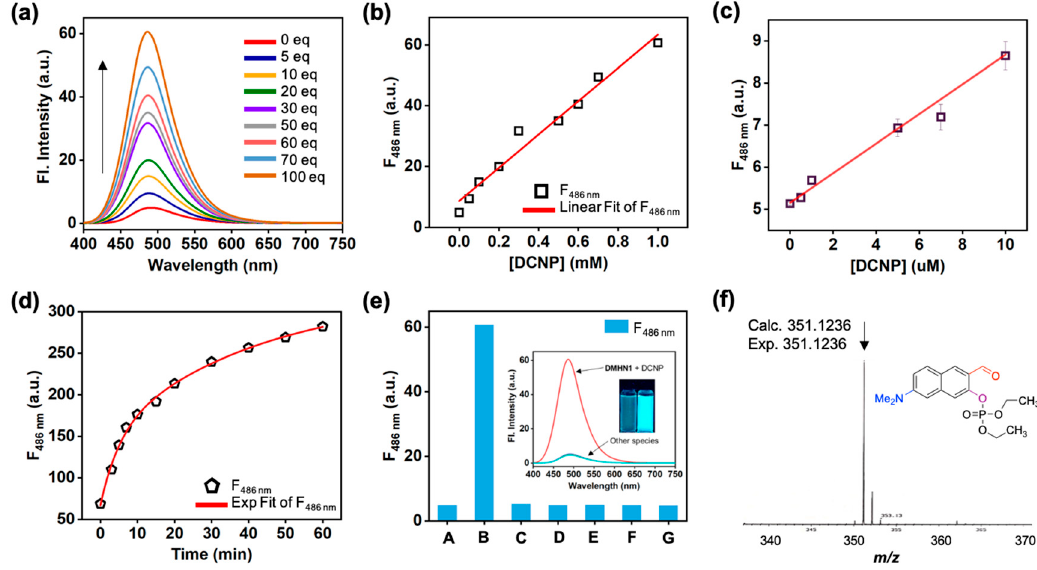
Figure 3. ( a ) Fluorescence change spectra of DMHN1 (10 μ M) measured immediately after adding DCNP (0–100 eq; 0–1 mM) gradually in CH 3 CN (1% Et 3 N) at 25 °C. ( b ) A plot of fluorescence intensity (peak height at 486 nm) changes of DMHN1 (10 μ M) with various concentrations of DCNP (0–1 mM). ( c ) Fluorescence intensity plot of DMHN1 (10 μ M) with a low concentration of DCNP (0.5–10 μ M). The emission spectra in the graph (a–c) were measured after 1 min under excitation at the maximum absorption wavelength. ( d ) A plot of fluorescence intensity (peak height at 486 nm) of DMHN1 (10 μ M) after adding DCNP (1 mM) in CH 3 CN (1% Et 3 N), measured for 60 min at 25 °C. ( e ) Fluorescence changes (peak height at 486 nm) of DMHN1 (10 μ M) measured immediately after adding various organophosphorus compounds (100 eq) in CH 3 CN (1% Et 3 N) at 25 °C. (A) DMHN1 , (B) DCNP: diethyl cyanophosphonate, (C) DCP: diethyl chlorophosphate, (D) DMMP: dimethyl methylphosphate, (E) TPP: triphenyl phosphate, (F) TEP: triethylphosphate, (G) CH 3 COOH: acetic acid. ( f ) HR-mass spectra of DMHN1 +DCNP.